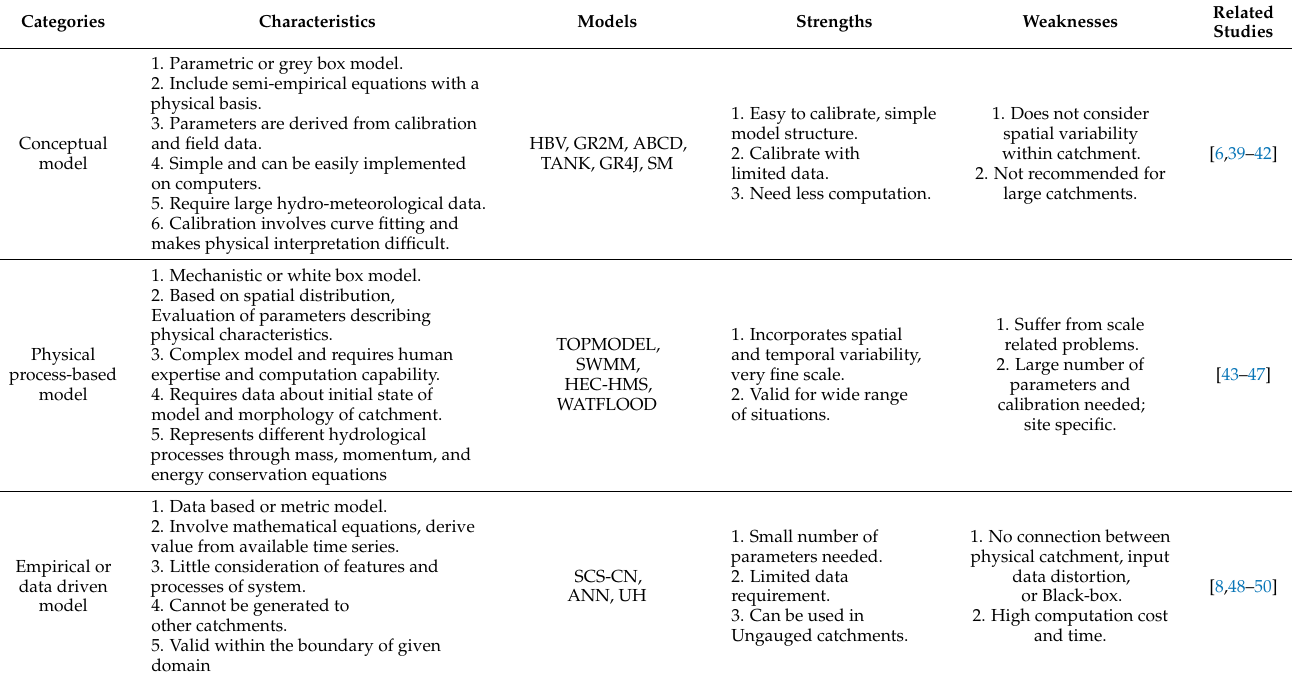
Table 1. Detailed description of conceptual, physical process-based, and empirical